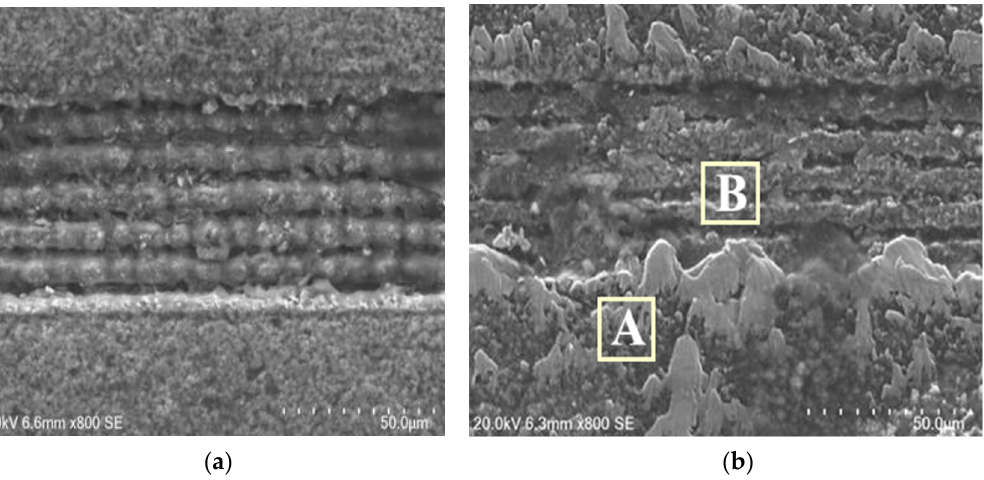
Figure 14. SEM images of microgroove texture before and after cutting. ( a ) Microgroove micro-texture processed by laser, ( b ) Microgroove micro-texture after cutting.